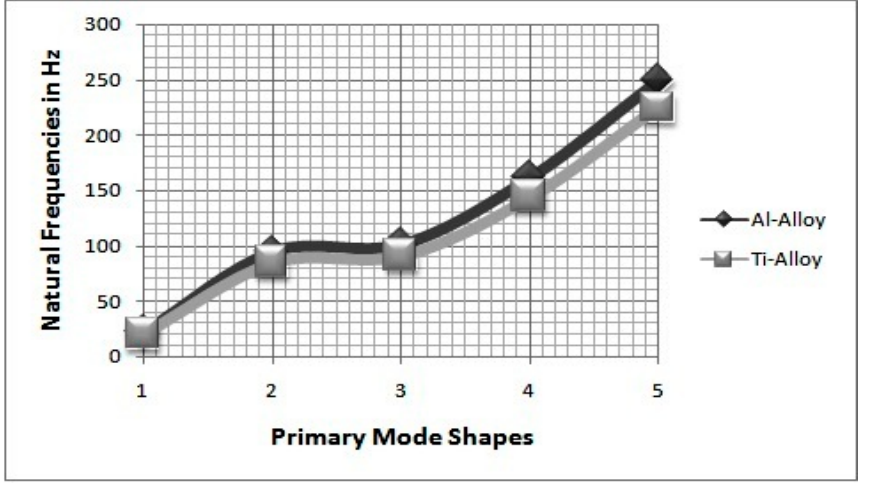
Figure 18. Comprehensive details of linear mode shapes versus natural frequencies for different alloys—Airplane Wing.